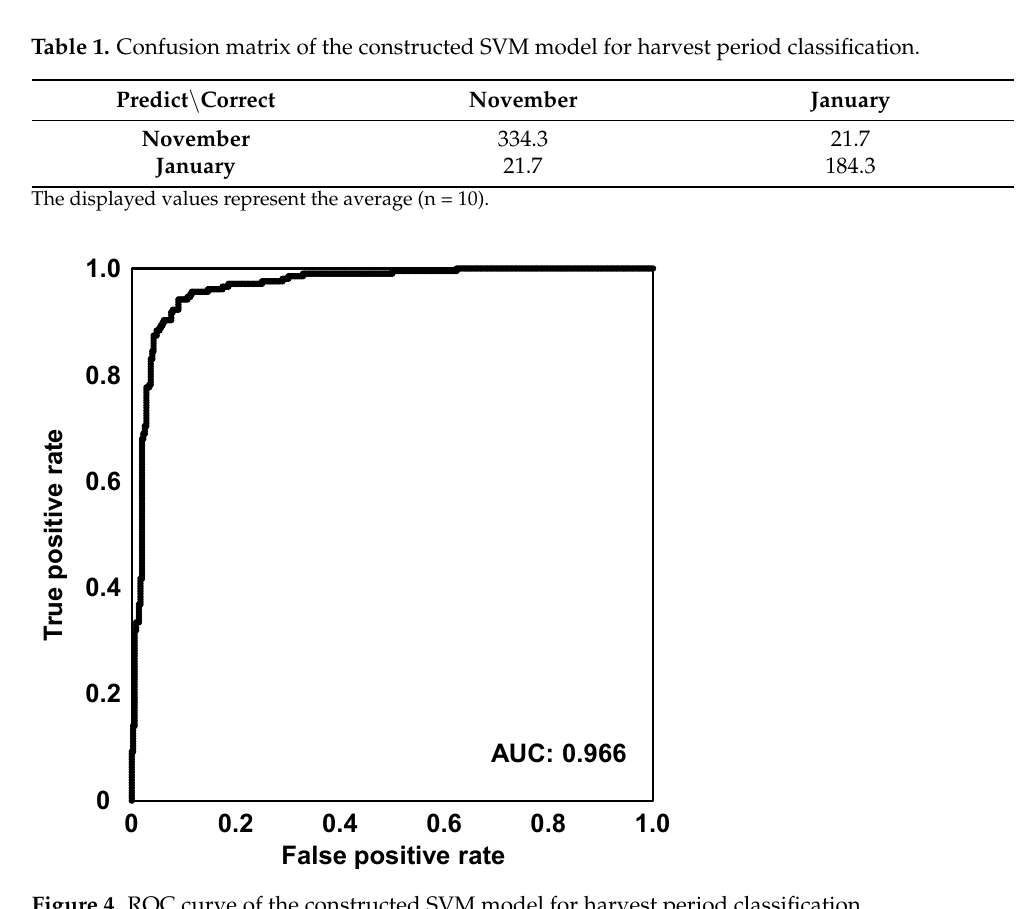
Figure 4. ROC curve of the constructed SVM model for harvest period classification.